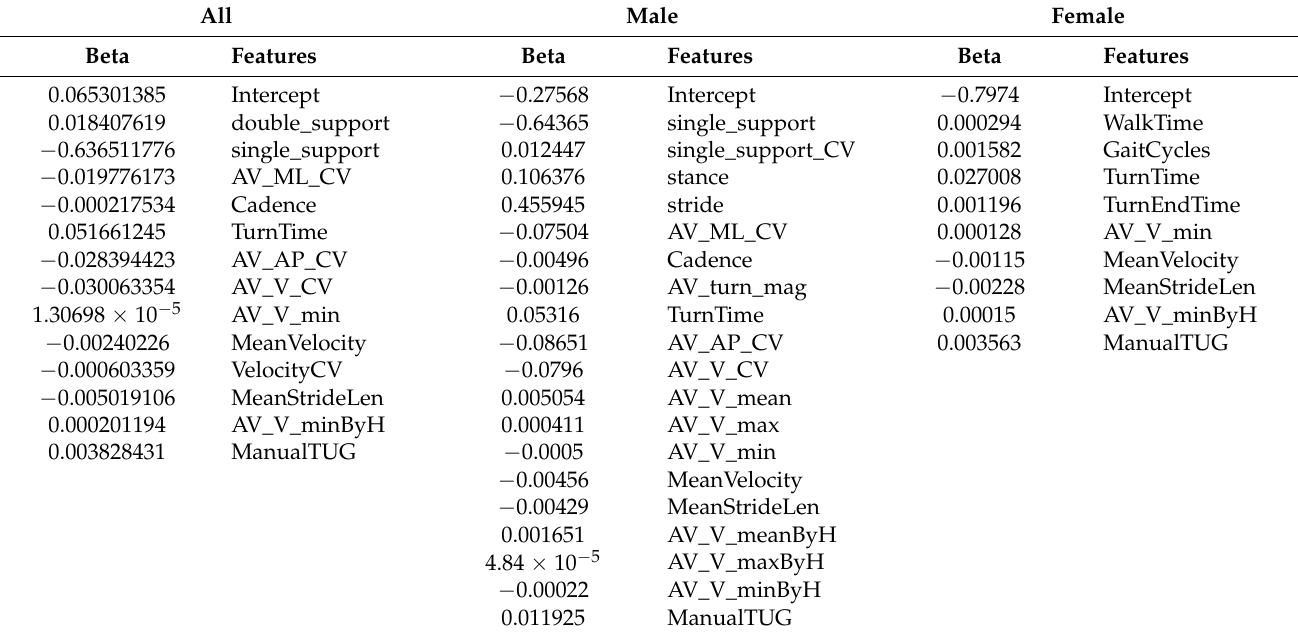
Table A10. TD-NoPD falls count model coefficients. Beta refers to Poisson regression coefficients, chosen through an elastic net